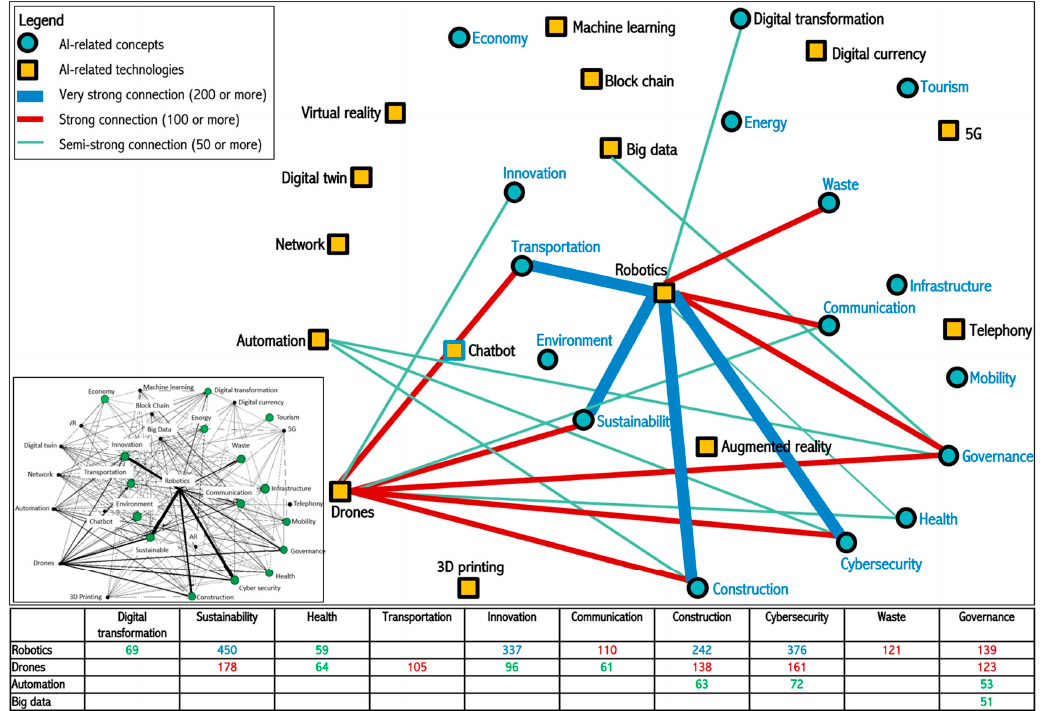
Figure 5. Relationships between AI technologies and urban planning and development concepts.